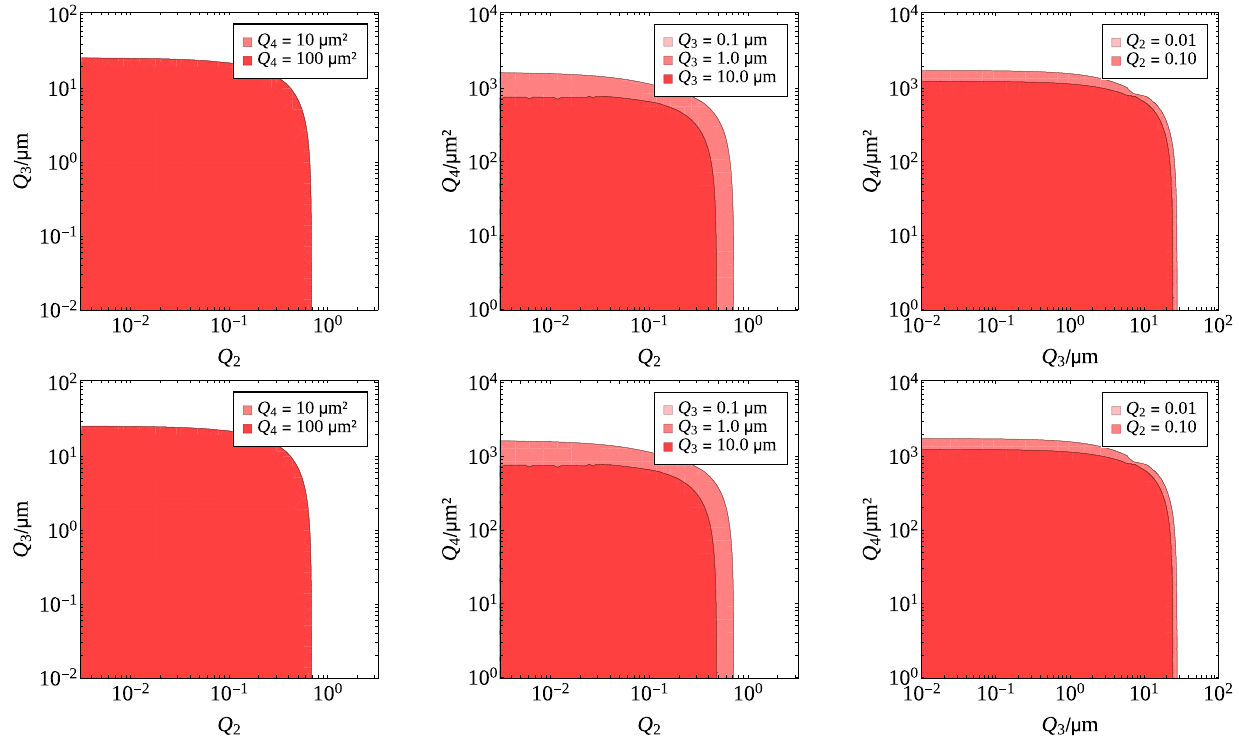
Fig. 11 Values of the background sources Q 2 , Q 3 and Q 4 (red shaded regions) for which no collision between S and P is observed when using the mN-potential. Within these regions neither the Newtonian nor the modified-Newtonian potential induce collision. From left to right,